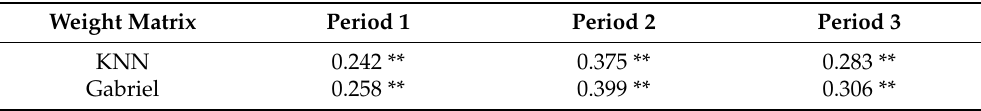
Table 1. Classical Moran’s I statistic for log return data of stock exchanges in 71 countries based on KNN and Gabriel connection network.